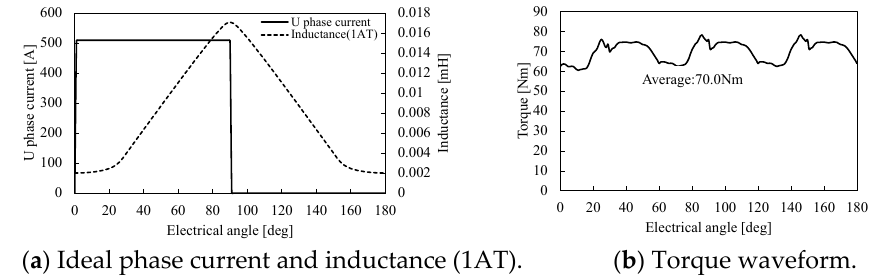
Figure 12. Torque waveform for applying ideal phase current.